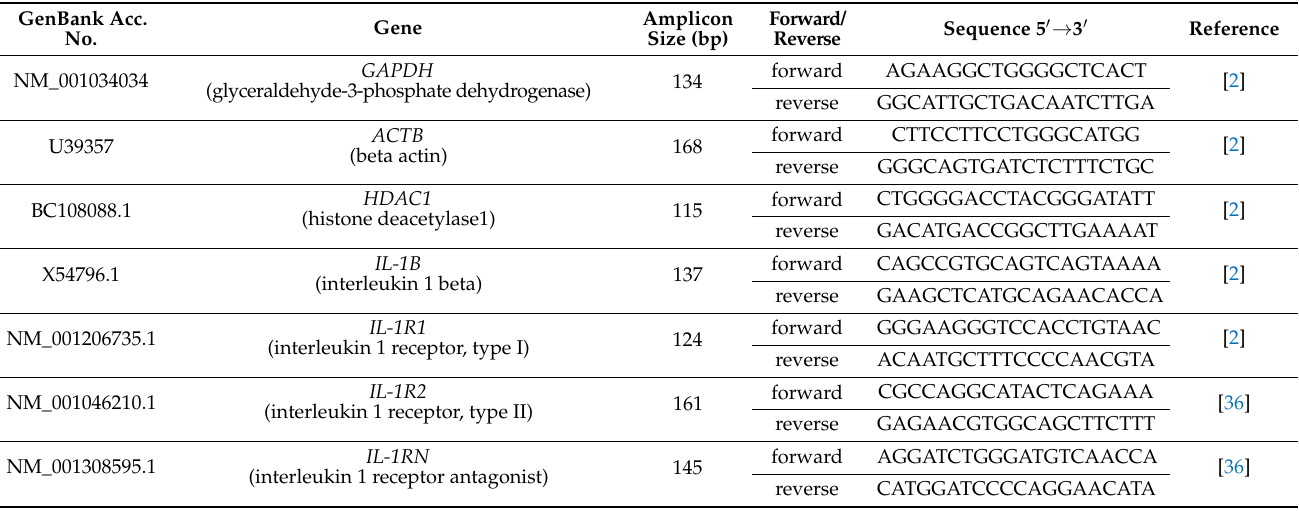
Table 2. The list of all genes analyzed by real-time PCR.